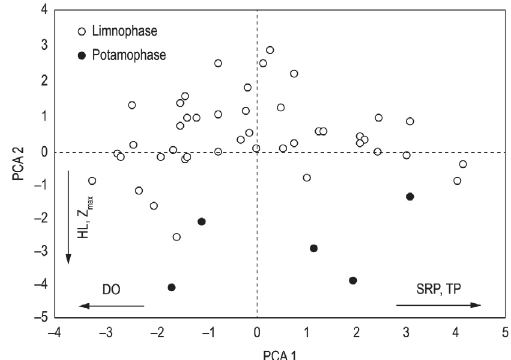
Figure 3. Dispersion of scores of the sampled periods along the first two axes of the Principal Component Analysis performed to summarize the environmental variability in Corutuba channel (DO - Dissolved Oxygen; SRP - Soluble Reactive Phosphorus; TP - Total Phosphorus; Z Maximum Depth; HL - Hydrometricl max -